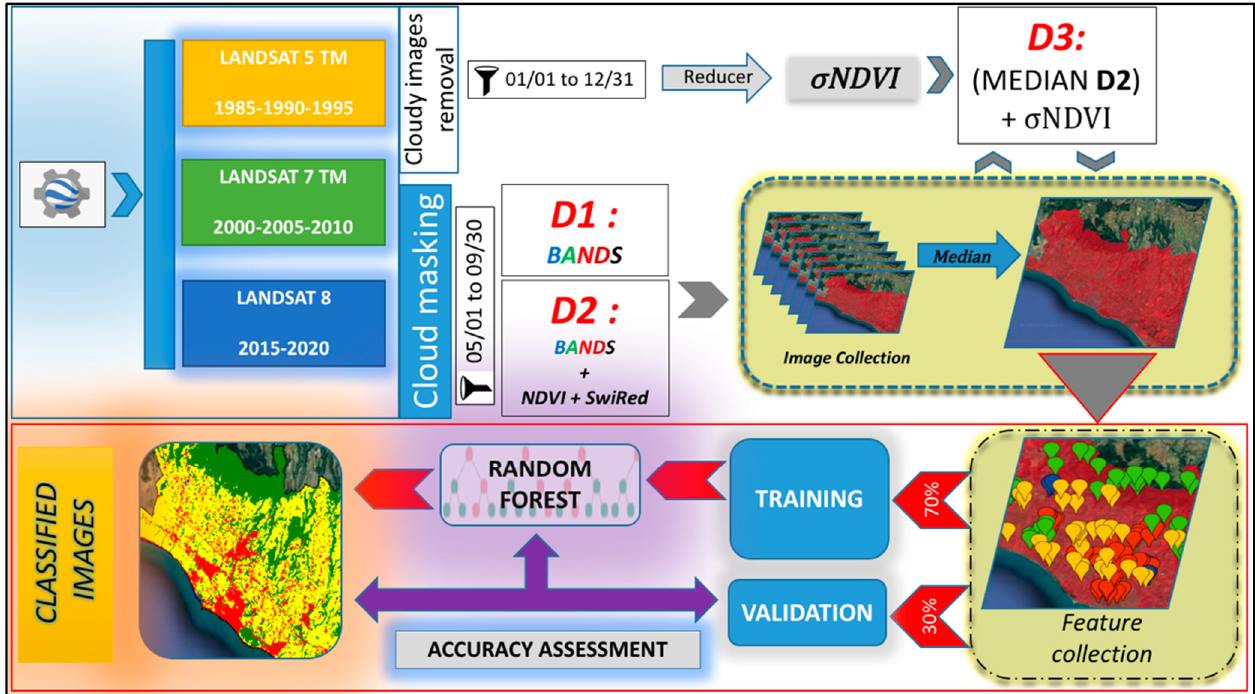
Figure 2. Image classification workflow for LCc analysis in GEE.